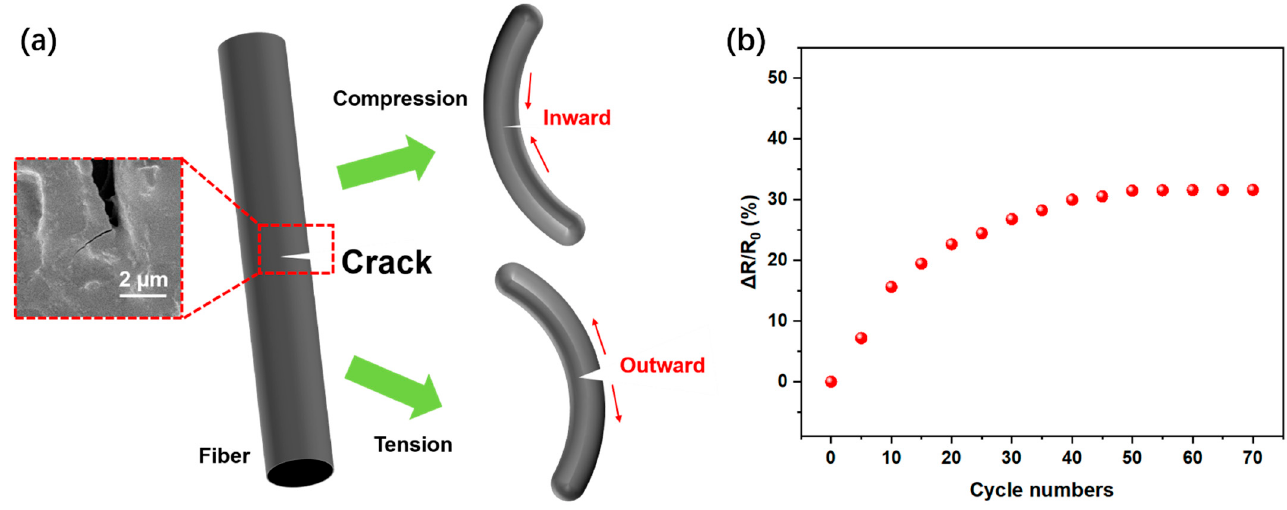
Figure 6. ( a ) Sensing mechanism of LCRF-based strain sensor. ( b ) Normalized resistance changes of sensor in the 70 pre-bending cycles.